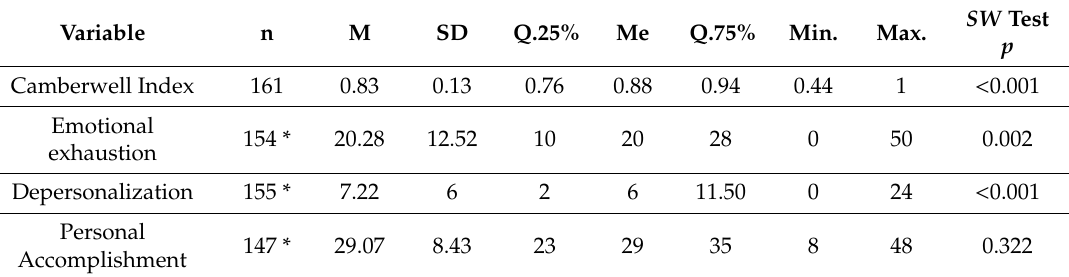
Table 3. Assessment of the level of needs and burnout among